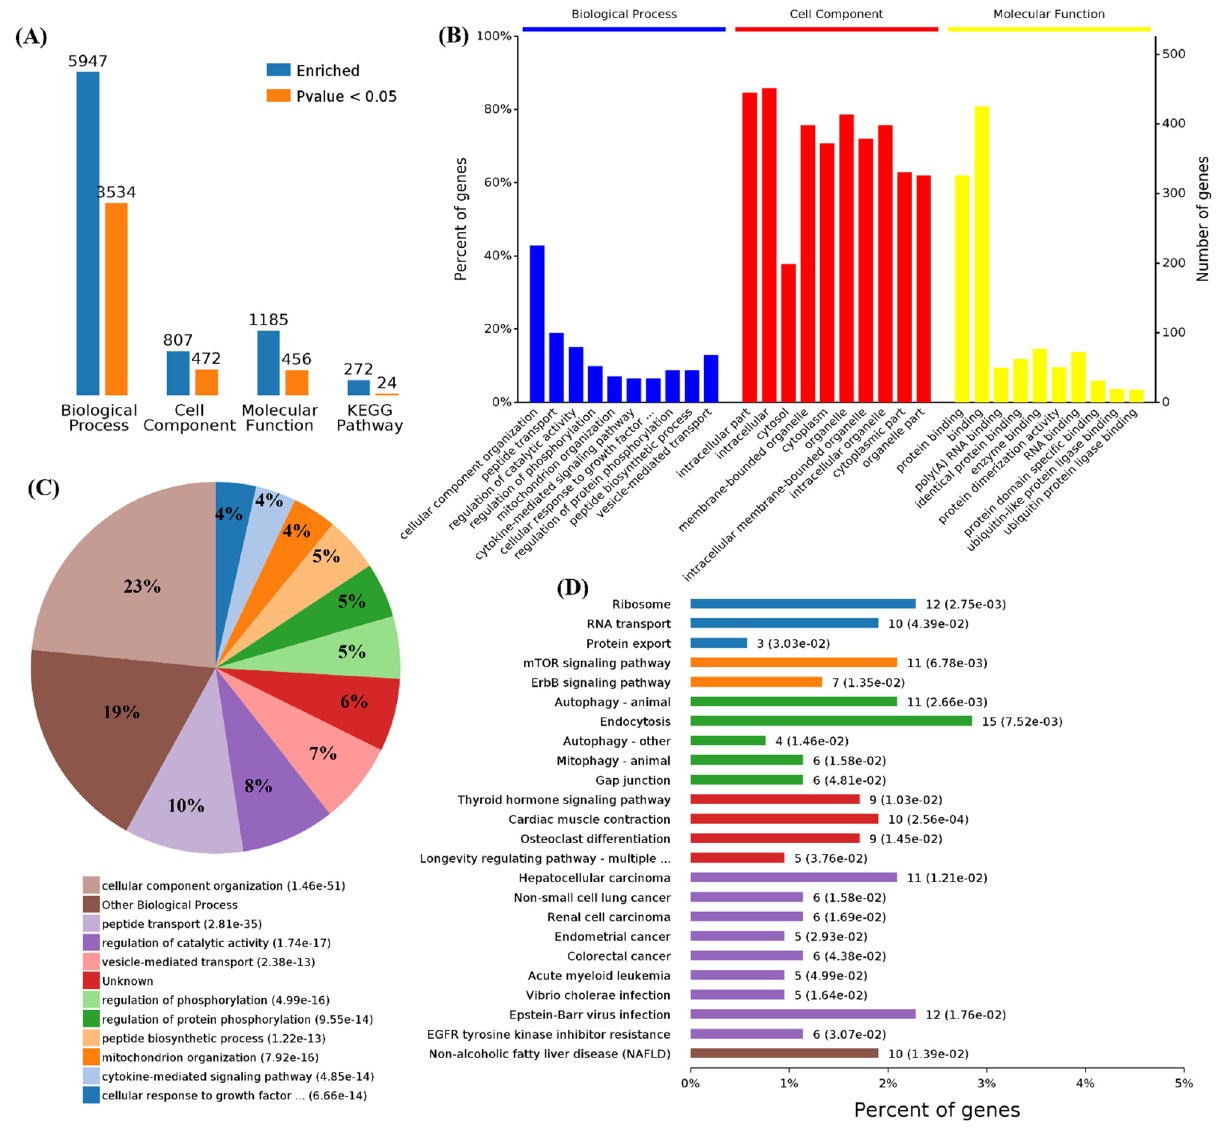
Figure 6. Functional enrichment and KEGG pathway analysis of SARS-CoV-2 alone induced down- regulated genes. ( A ) Number of downregulated genes enriched in GO terms and KEGG pathways. ( B ) Overview of significantly enriched biological process, cell component, and molecular function of the downregulated genes induced by SARS-CoV-2 infection. ( C ) Pie chart of enriched biological processes of the downregulated genes. ( D ) Percentage of genes related to enriched KEGG pathways.